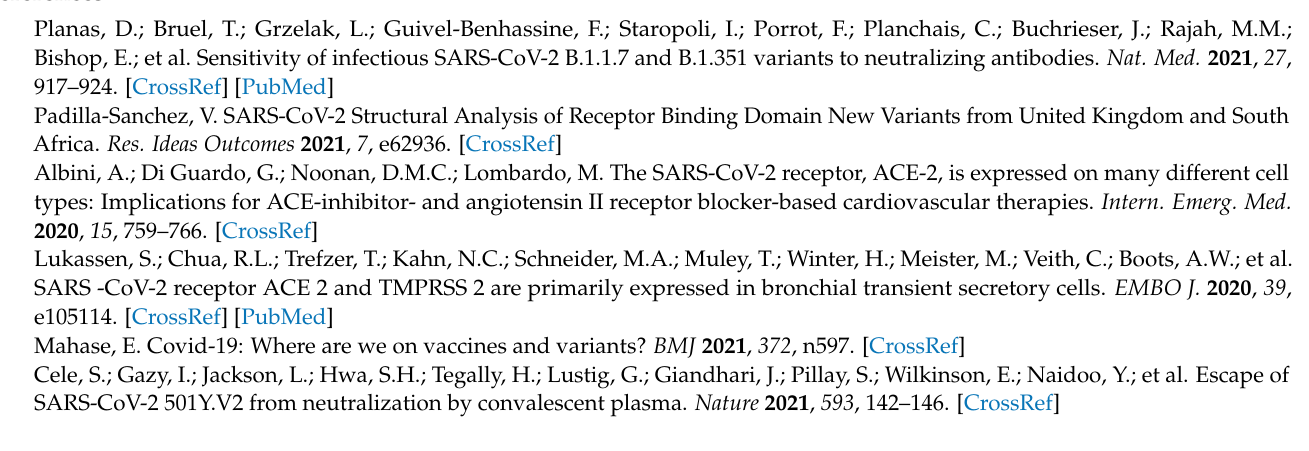
the 3D (A) and 2D (B) interactions between bromelain-derived peptide and RBD SA by LigPlot+. RBD SA contains the mutations K417N, E484 and N501Y. Figure S2: Sketch diagram depicting the 3D (A) and 2D (B) interactions between bromelain-derived peptide and RBD UK by LigPlot+. RBD UK contains the mutation N501Y. Figure S3: Sketch diagram depicting the 3D (A) and 2D (B) interactions between bromelain-derived peptide and RBD CA (US) by LigPlot+. RBD CA contains the mutation L452R. Figure S4. Sketch diagram depicting the 3D (A) and 2D (B) interactions between bromelain- derived peptide and RBD SG (NY1) by LigPlot+. RBD SG contains the mutation S477G. Figure S5. Sketch diagram depicting the 3D (A) and 2D (B) interactions between bromelain-derived peptide and RBD SN (NY2) by LigPlot+. RBD SN contains the mutation S477N. Figure S6. Sketch diagram depicting the 3D (A) and 2D (B) interactions between bromelain-derived peptide and RBD SC by LigPlot+. RBD SC contains the mutation N439K. Figure S7. Sketch diagram depicting the 3D (A) and 2D (B) interactions between bromelain-derived peptide and RBD NG by LigPlot+. RBD NG contains the mutation E484K. Figure S8. Sketch diagram depicting the 3D (A) and 2D (B) interactions between bromelain peptide and RBD IN by LigPlot+. RBD IN contains the mutations L452R and